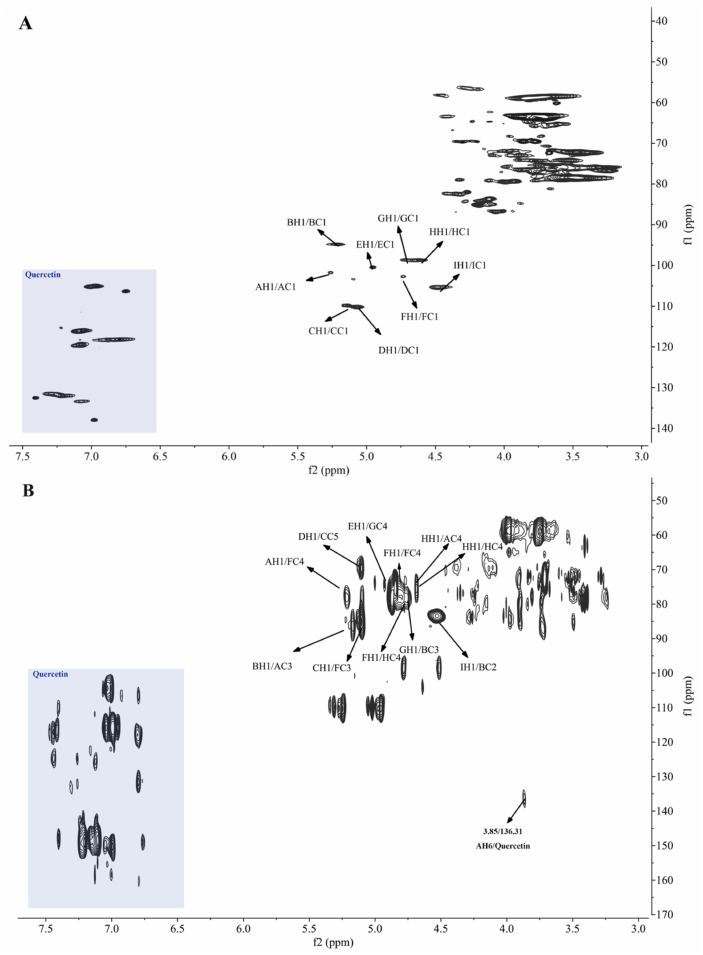
Figure 3. HSQC ( A ) spectrum and HMBC ( B ) spectrum of